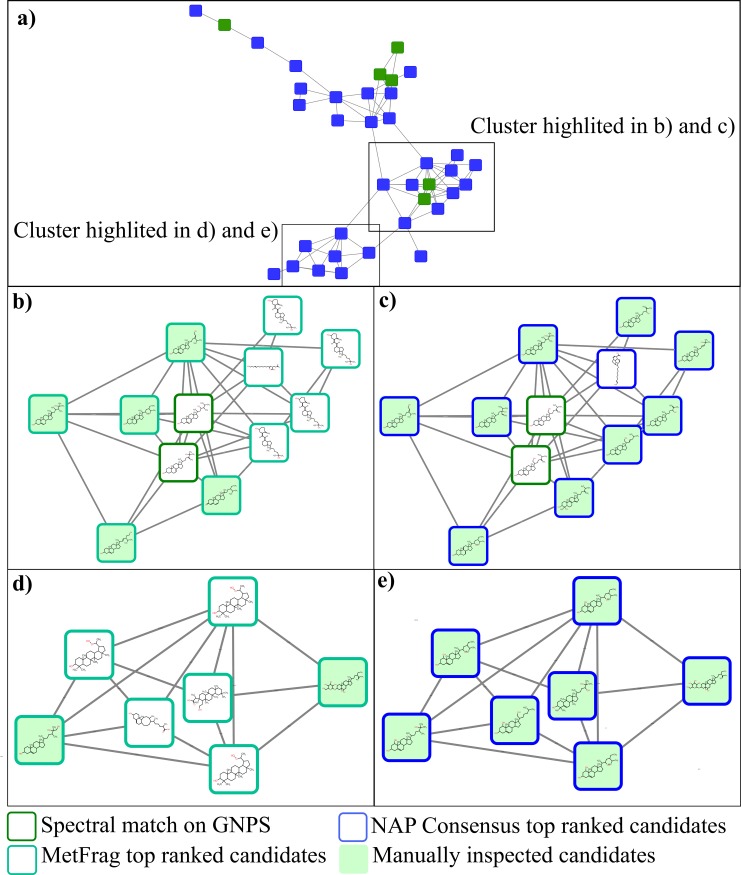
Network annotation of the T. septentrionalis fungus gardens extracts with NAP and visualized in Cytoscape with ChemViz2 plug-in.a) Group of nodes in which the annotation can be directly propagated from spectral library matches (top) and other in which the inspection of neighbor candidate structures can improve the annotation (bottom). Blue background nodes represent the presence of candidate structures from in silico annotation and green background represents candidates from spectral library annotation. b) MetFrag top ranked candidates. c) NAP consensus top ranked candidates. d) MetFrag top ranked candidates. e) NAP consensus top ranked candidates.